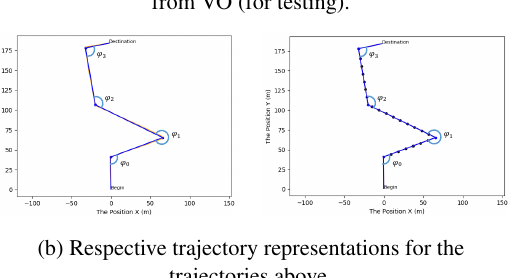
(b) Respective trajectory representations for the trajectories above. Figure 5. Illustrated trajectory representation, including synthetic trajectory and real trajectories and respective representations generated for the synthetic and real trajectory. } . Note that, the choice of 20 bins is , . . . , ψ (cid:48) { ψ (cid:48) n − 2 1